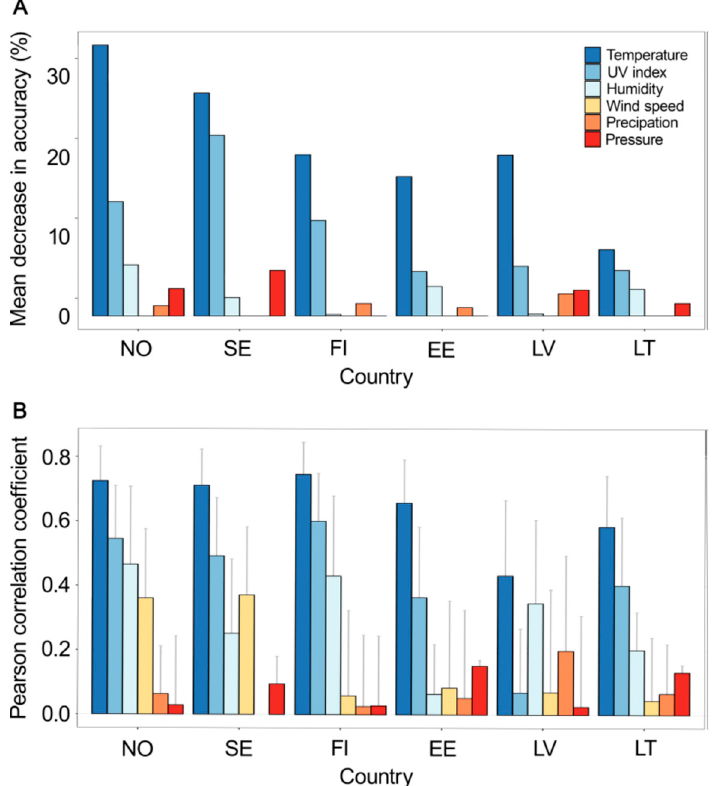
Figure 2. Association between six meteorological factors (temperature, UV index, humidity, wind speed, precipitation, and pressure) and influenza activity in six Northern Europe countries (Norway, Sweden, Finland, Estonia, Latvia and Lithuania) between week 35 of 2017 and week 34 of 2018. ( A ) Contribution of each meteorological factor to predictive performance of a machine learning Random Forest model trained to predict influenza activity. The contribution is measured as percentage mean decrease in accuracy (the higher the bar, the more important the factor). ( B ) Correlation between meteorological factors and influenza activity. Absolute values of Pearson correlation coefficient (95% confidence interval) are shown.